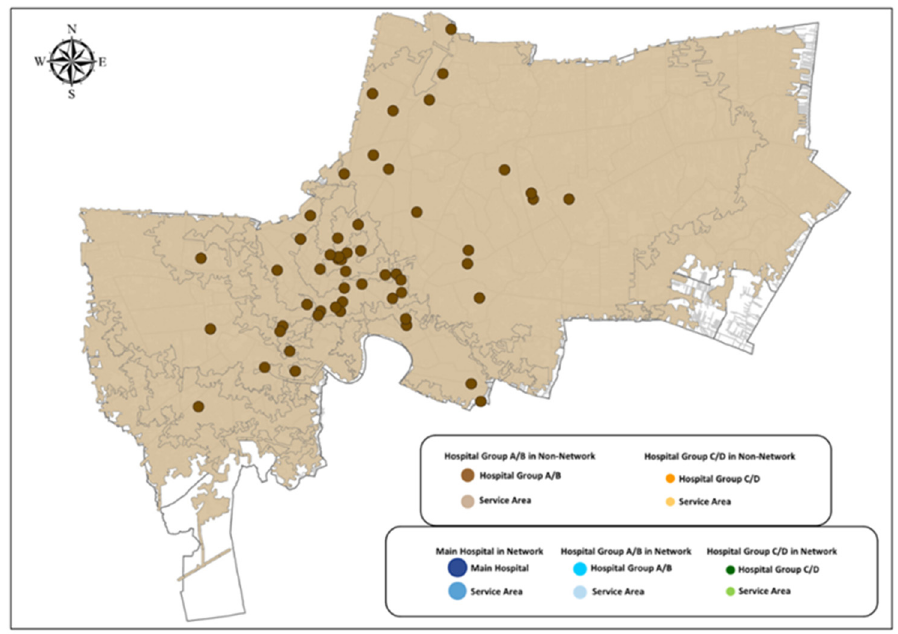
Figure 9. Service area of non-network hospitals in Group A/B.